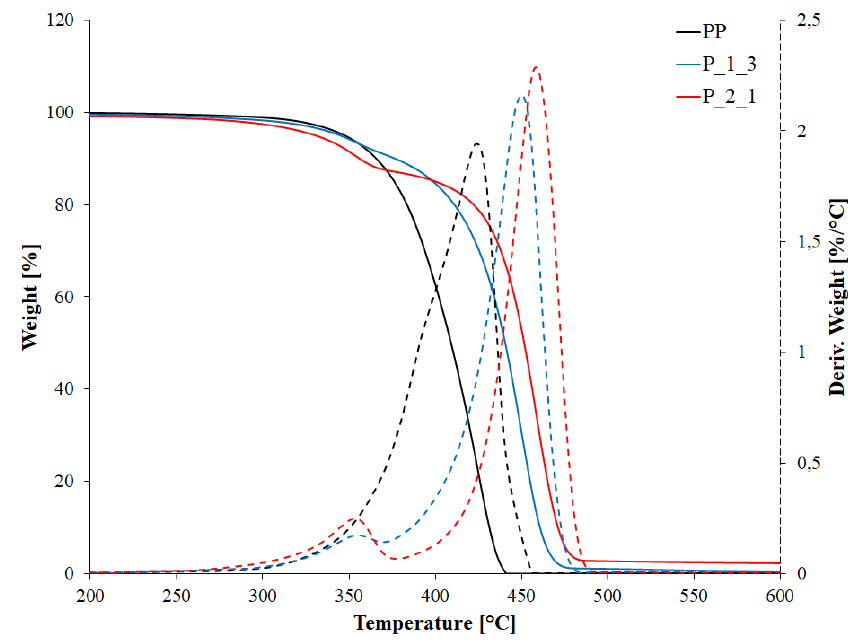
Figure 9. TG (solid line) and DTG (dashed line) curves of selected samples. Table 4. The results of the thermogravimetric analysis (TG) of individual samples.